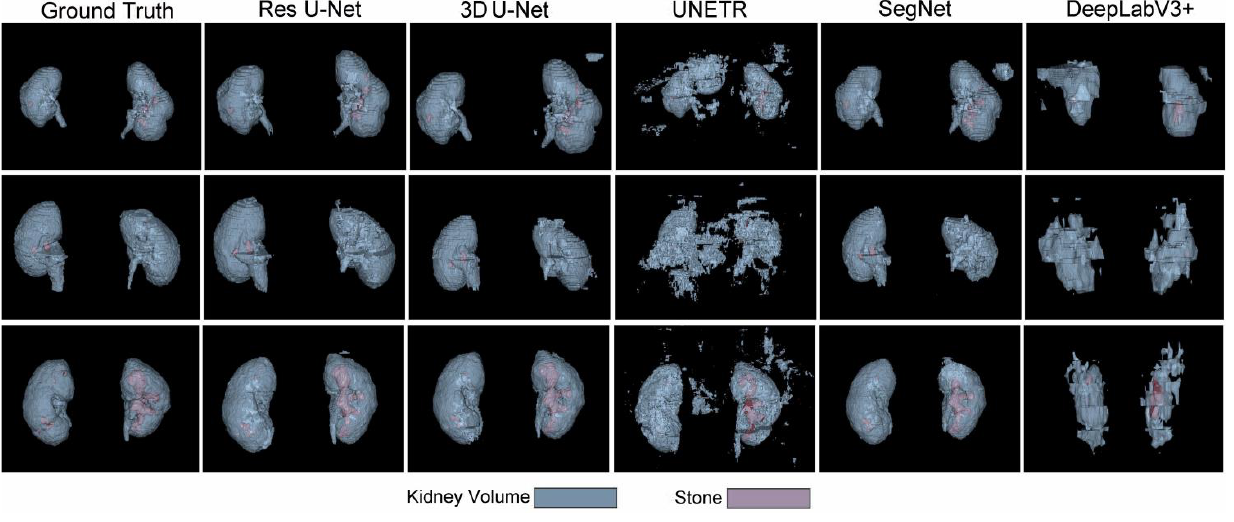
Figure 16. The 3D visual analysis of predictions generated by the models trained dependently.